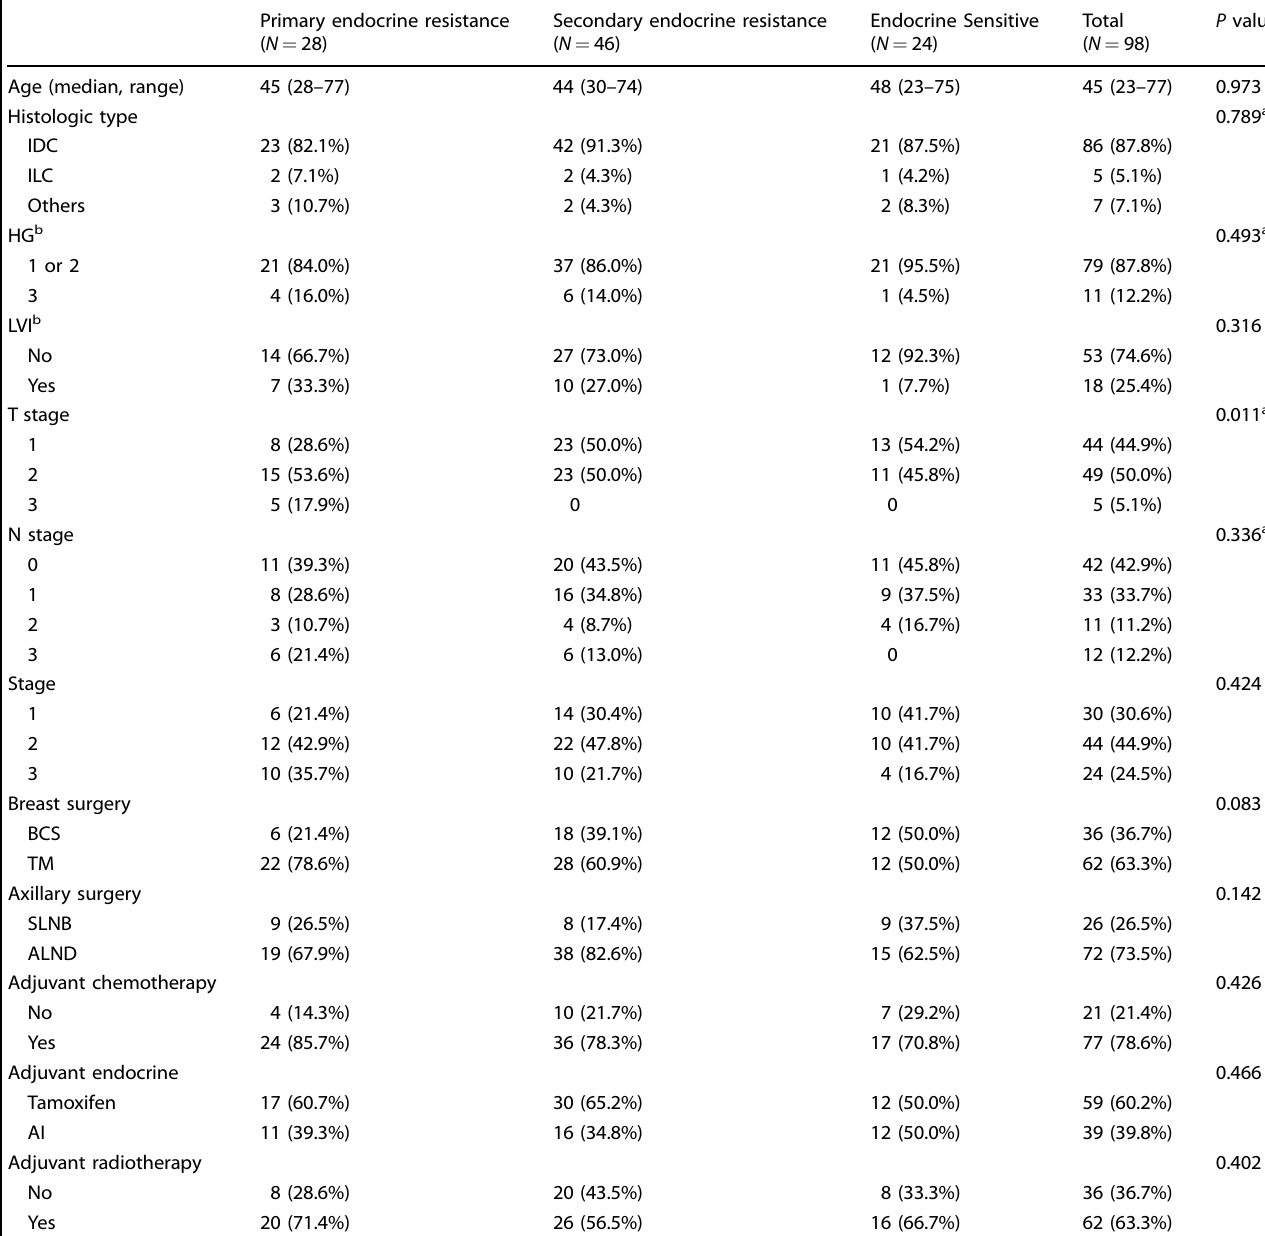
Table 1. Baseline characteristics according to endocrine resistance in patients who received adjuvant endocrine